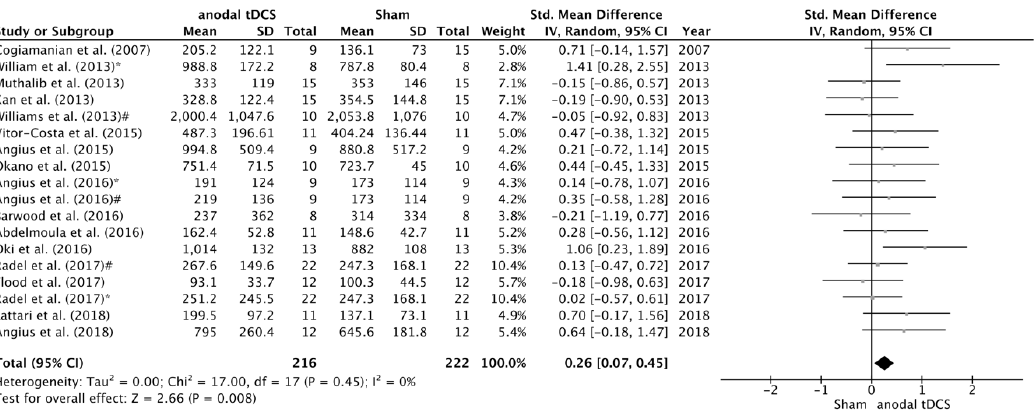
anodal tDCS using an extracephalic montage (Anode in M1 and Cathode in shoulder).